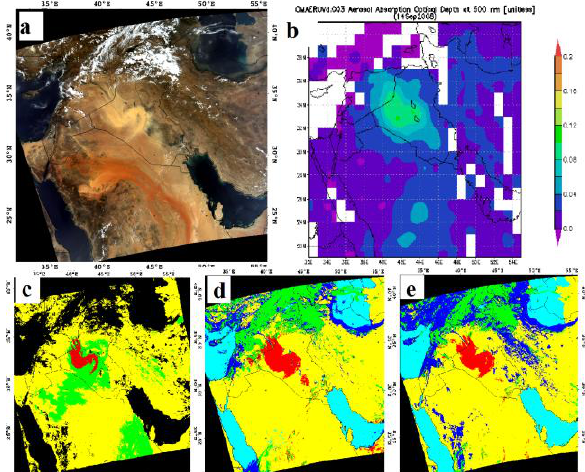
Figure 5. Comparison of detected dust storm in 4 Mar 2010 with true color image and OMAERUV product, a) true color image, b) OMAERUV product, c) decision tree result, d) MLP result, and e) SVM